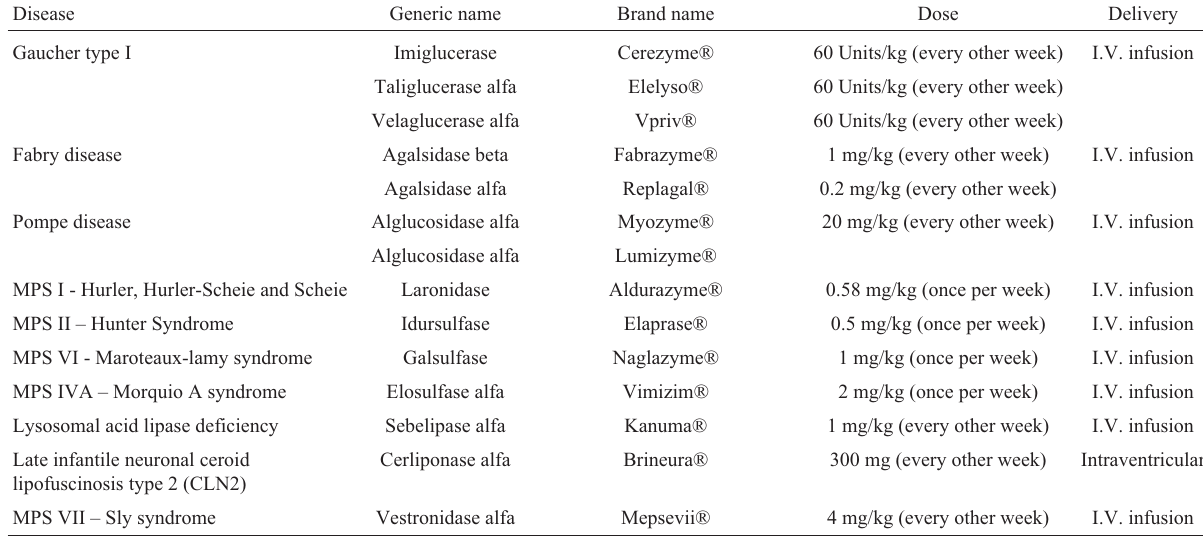
Table 3 - Approved enzyme replacement therapies